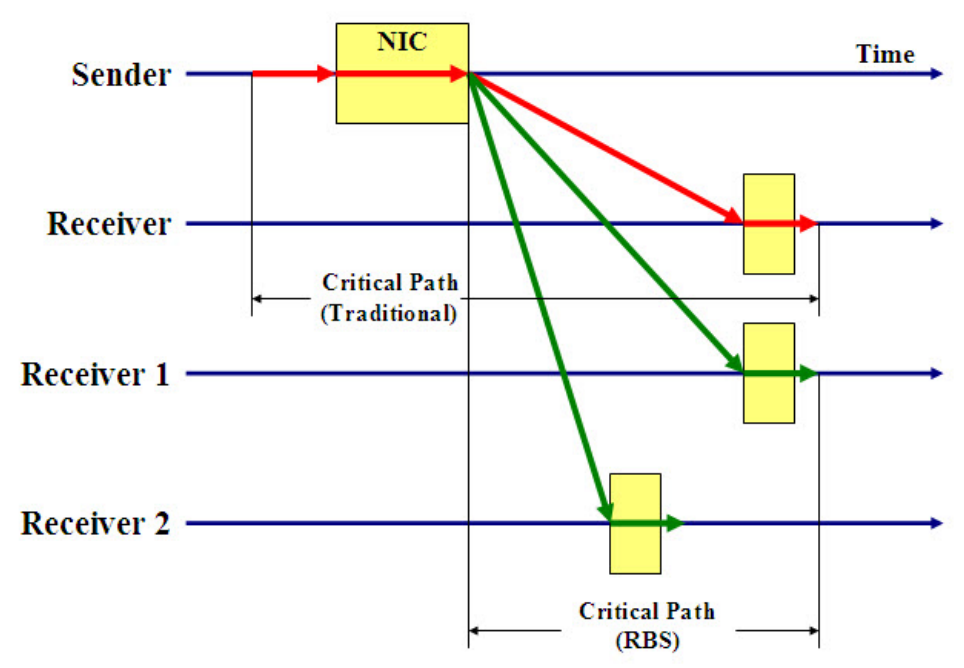
Figure 3. A critical path analysis for traditional time synchronization protocols and